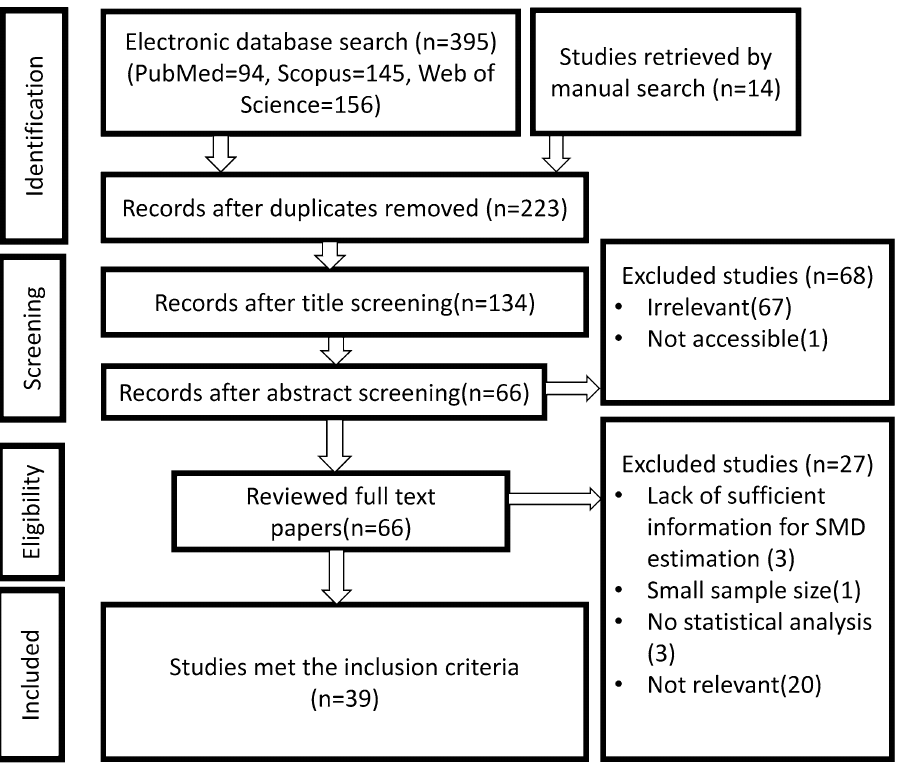
Figure 1. Flow diagram of the search procedure according to the PRISMA